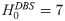
Response of the network model in the case of periodic stimulation patterns.The graphs (A-B) show the β-Power and root mean square value of the activity computed from the cortical LFP signal (Eq 9), when a periodic stimulation pattern configured with a pulse width of δ = 0.5 ms was applied to the STN nuclei. β-Power and the root mean square value of the activity as a function of the stimulation frequency fDBS, keeping the stimulation amplitude unchanged at H0DBS=7. The β-Power has been normalized with respect to that obtained for the system in the oscillatory state without stimulation (H0DBS=0). Besides, the 〈ACrms〉 correspond to the root mean square value of the activity averaged over all the cortical neurons. The frequency for the period doubling bifurcation fd ∼ 25 Hz and the frequency for activity total suppression fs ∼ 130 Hz, are indicated with solid vertical lines in order to highlight the transition points between the three states of the system: (1) Null activity (fDBS > fs), (2) β-Power suppression (fd < fDBS < fs) and (3) Pathological β-Power (fDBS < fd).